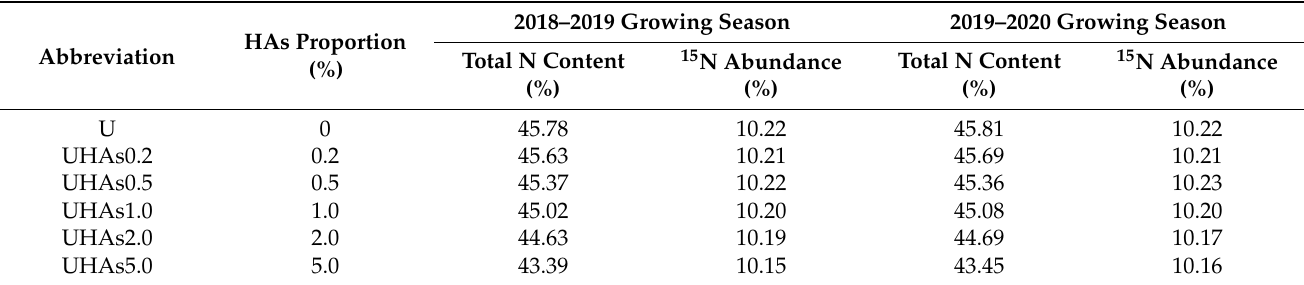
Table 1. N content and 15 N abundance of prepared U and UHAs in this study.